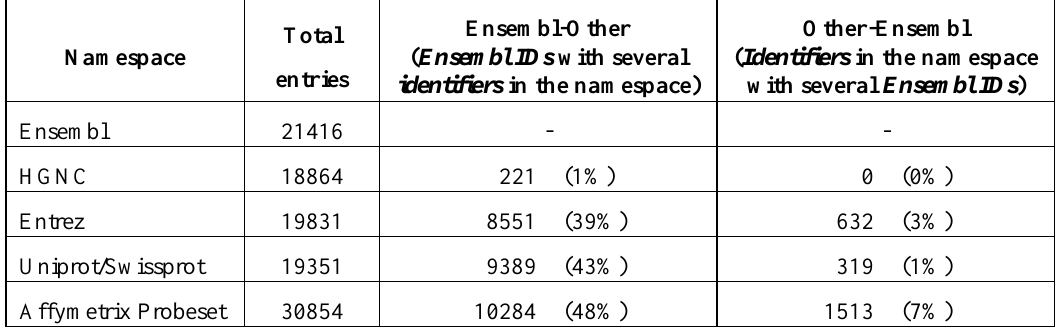
Table 3: PathJam dictionary summary. Built from Ensembl 55 Homo sapiens database